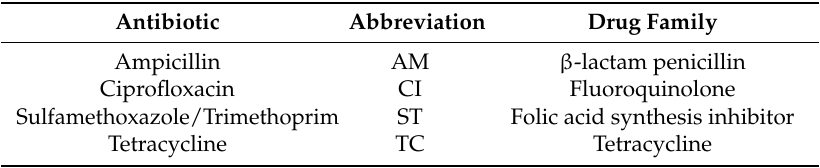
Table 1. Antibiotics used in the